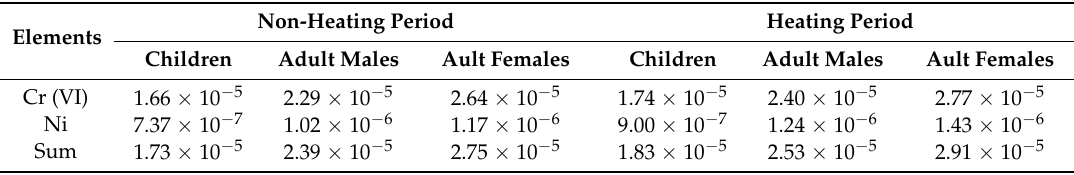
Table 10. The carcinogenic risks of heavy metals via dermal exposure.